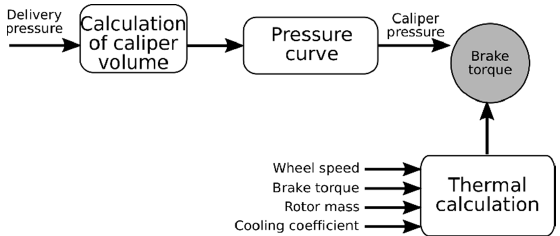
Figure 3. Brake system—basic scheme of generating mechanical braking torque.